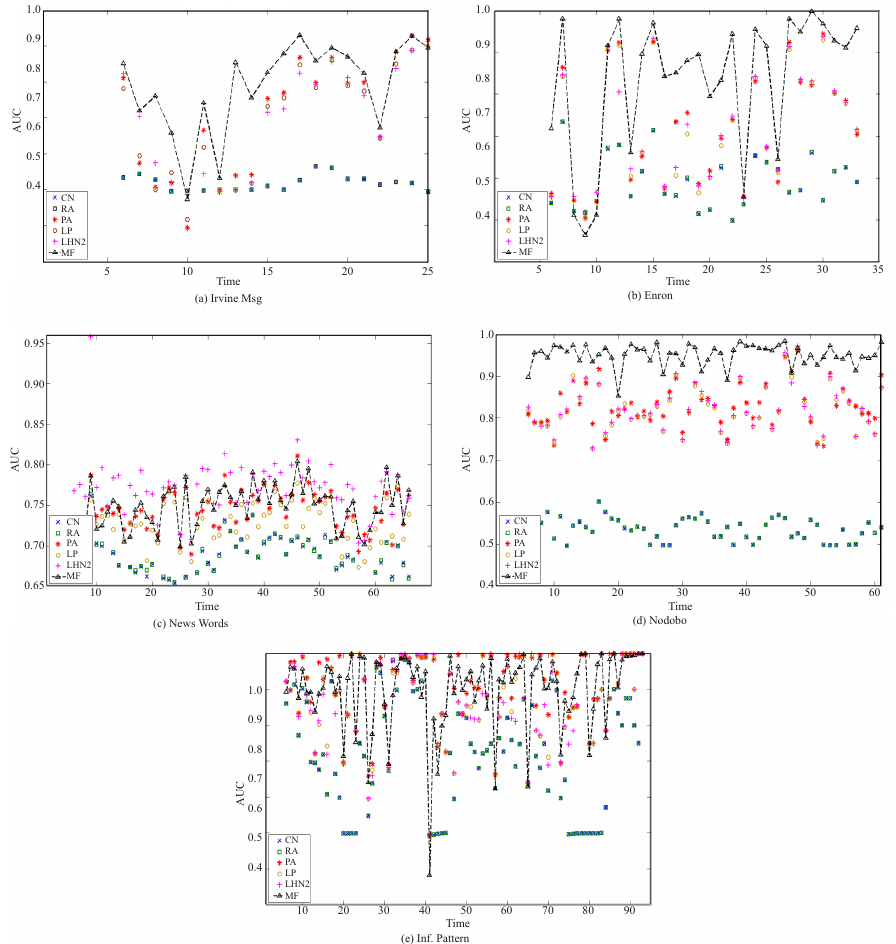
Fig. 1 Performance of MF and other methods.